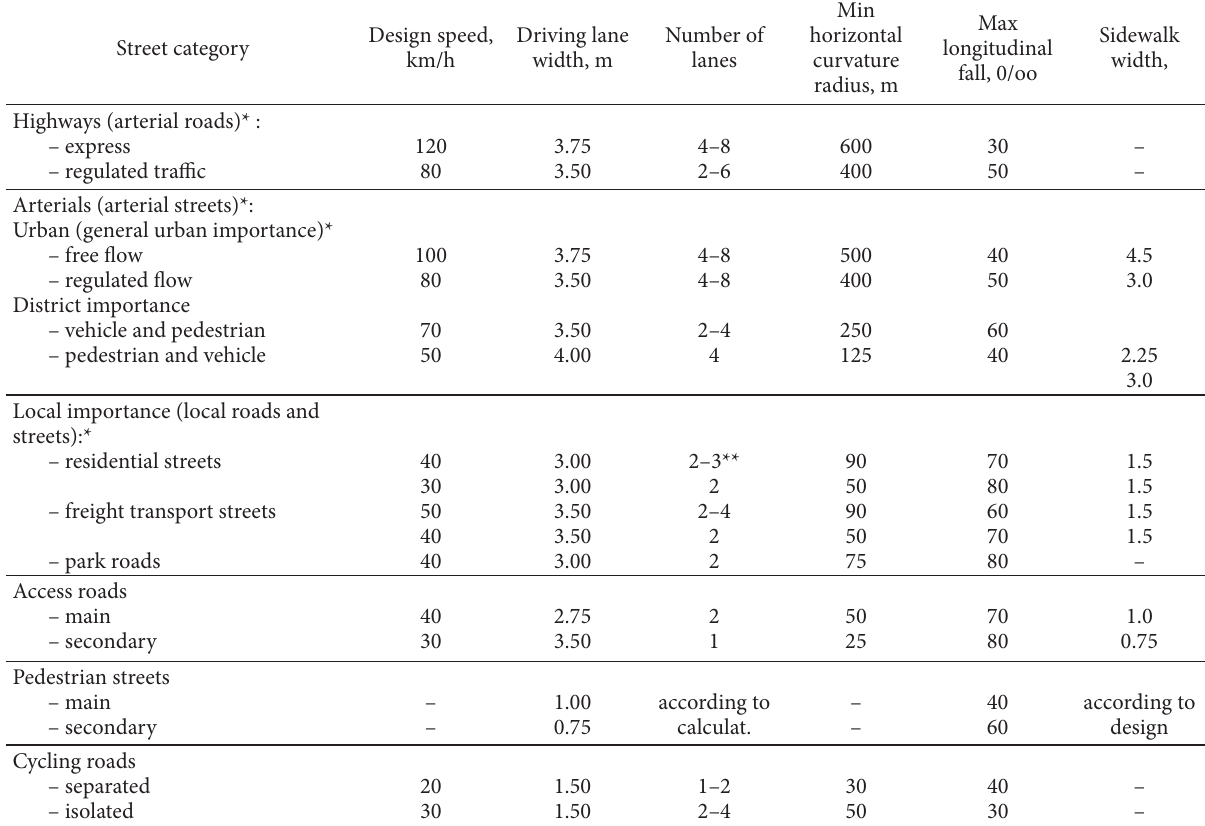
Table 2. Calculation parameters for urban streets specified in norms ( LBN 100 ; СниП 1989